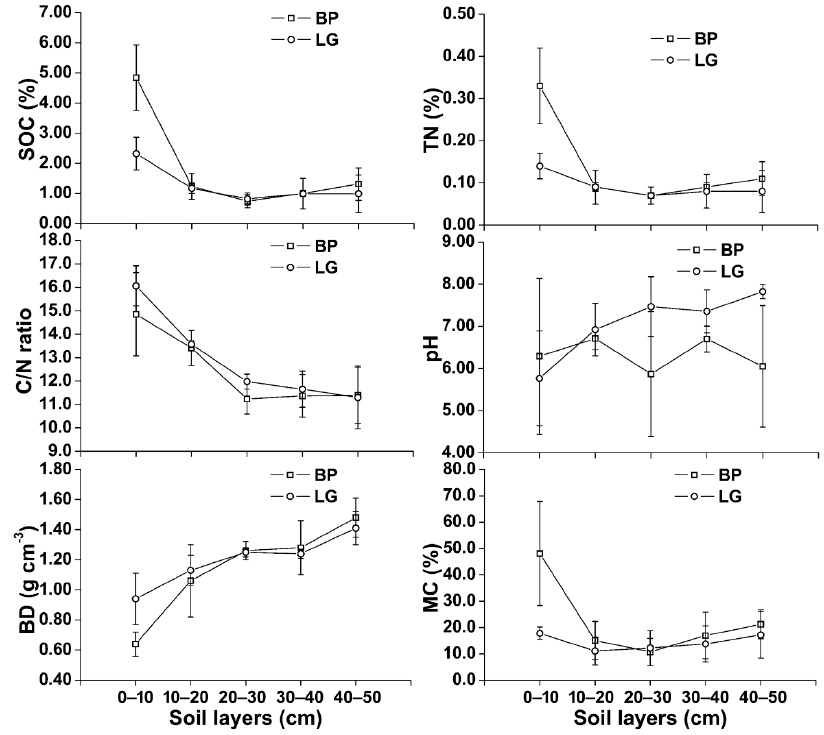
Figure 3. Vertical distributions of soil properties of B P and L G.